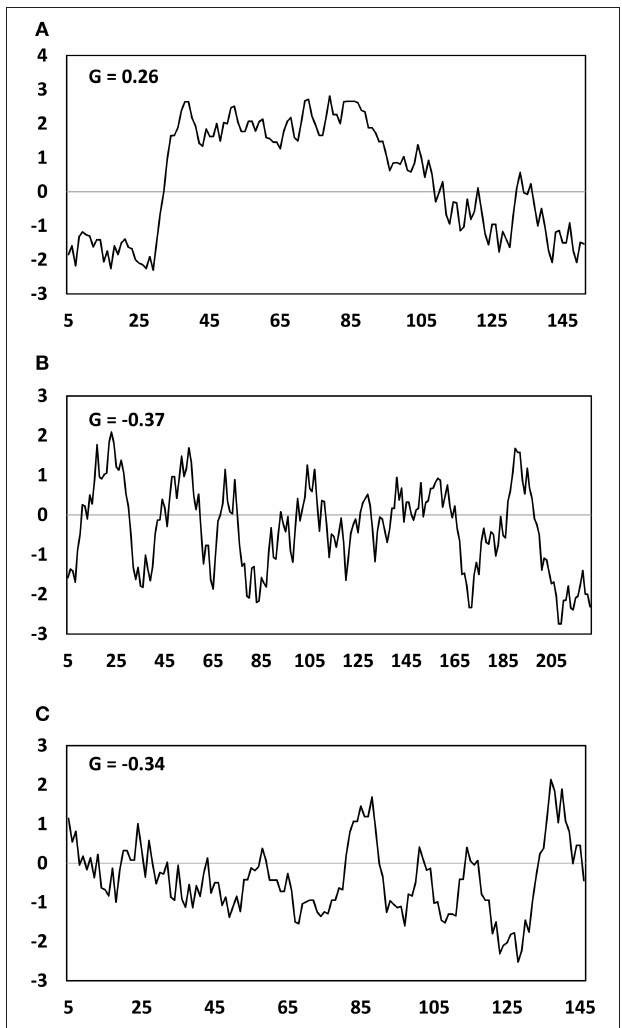
FIGURE 8 | Hydropathy plot of Oleosin (A) , LDAP (B) , MLP-like (C) deduced amino acid sequences from the Triadica sebifera proteomic analysis. G represents the GRAVY- grand average of hydropathy value.